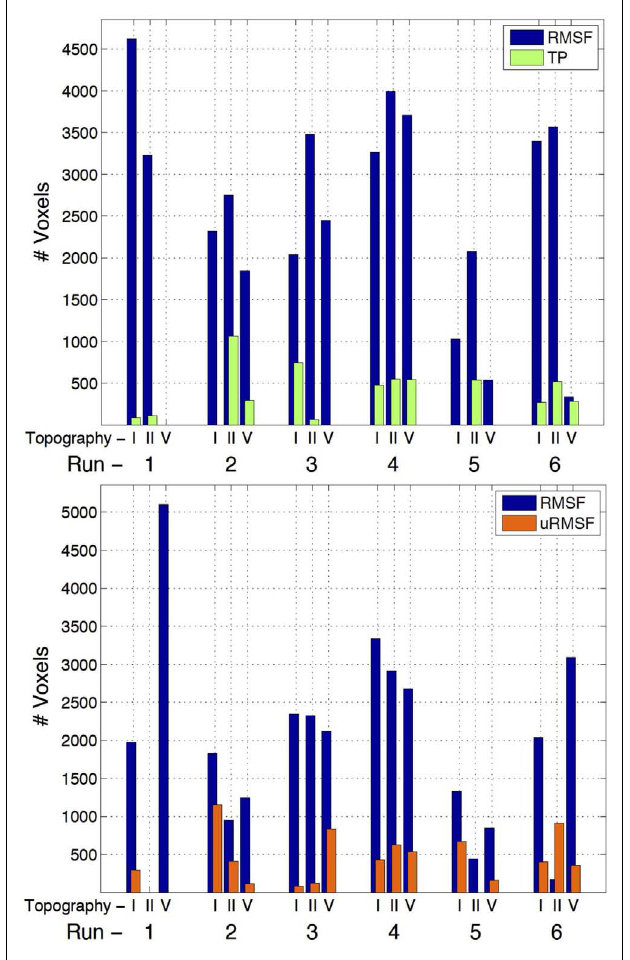
FIGURE 4 | Number of voxels exhibiting statistically significant EEG metric-related BOLD changes, for the two-way comparisons RMSF vs. TP (top) and RMSF vs. uRMSF (bottom), for each IC group (II,V, and I) and each run (1–6).